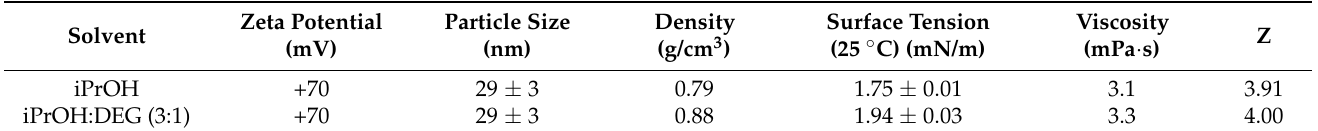
Table 2. Characterization of the inks.